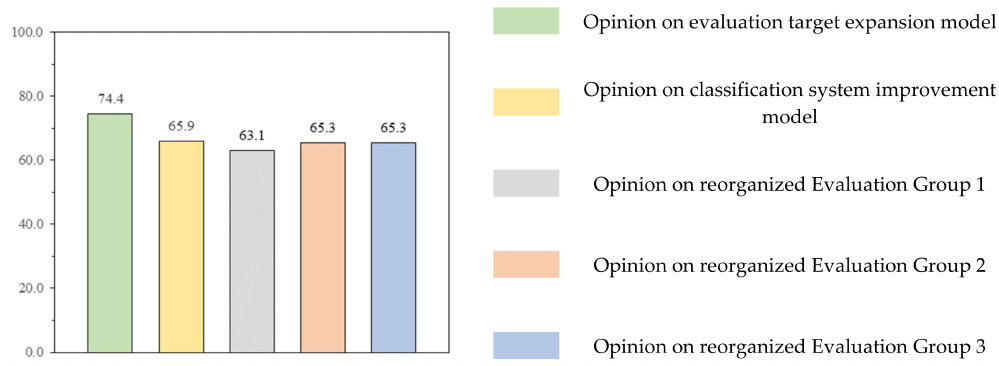
Figure 11. Survey weighted score for evaluation targets and the classification improvement